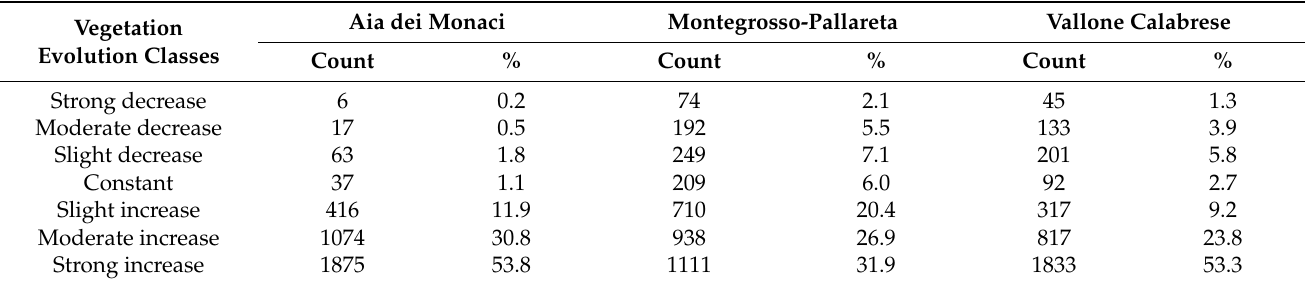
Table 3. Percentage distribution of the vegetation evolution classes in the survey sites.